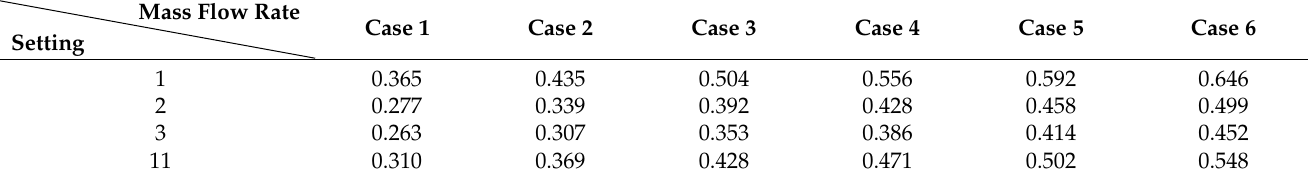
Table 2. The inlet mass flow rate in the present four settings (kg/s).